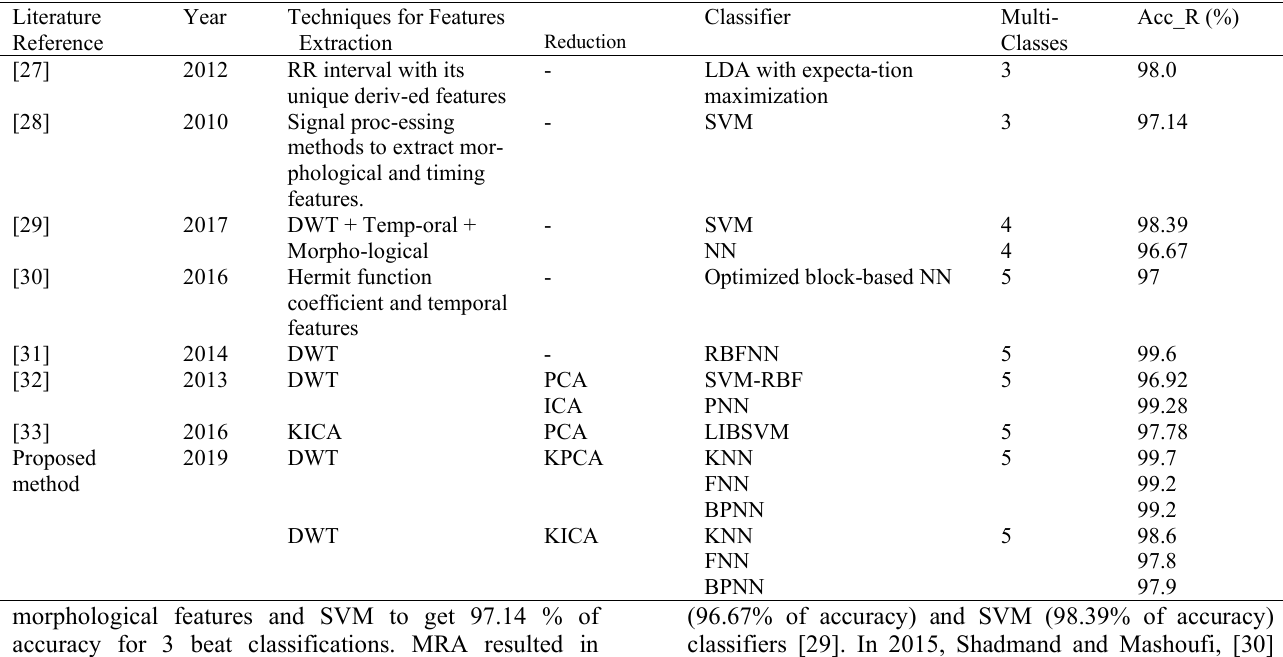
Figure 6 . Outcomes of five different folds of classifiers using KPCA and KICA Table 5. Performance comparisons showing the analysis between proposed method and existing cardiac arrhythmia classifications using ‘MIT-